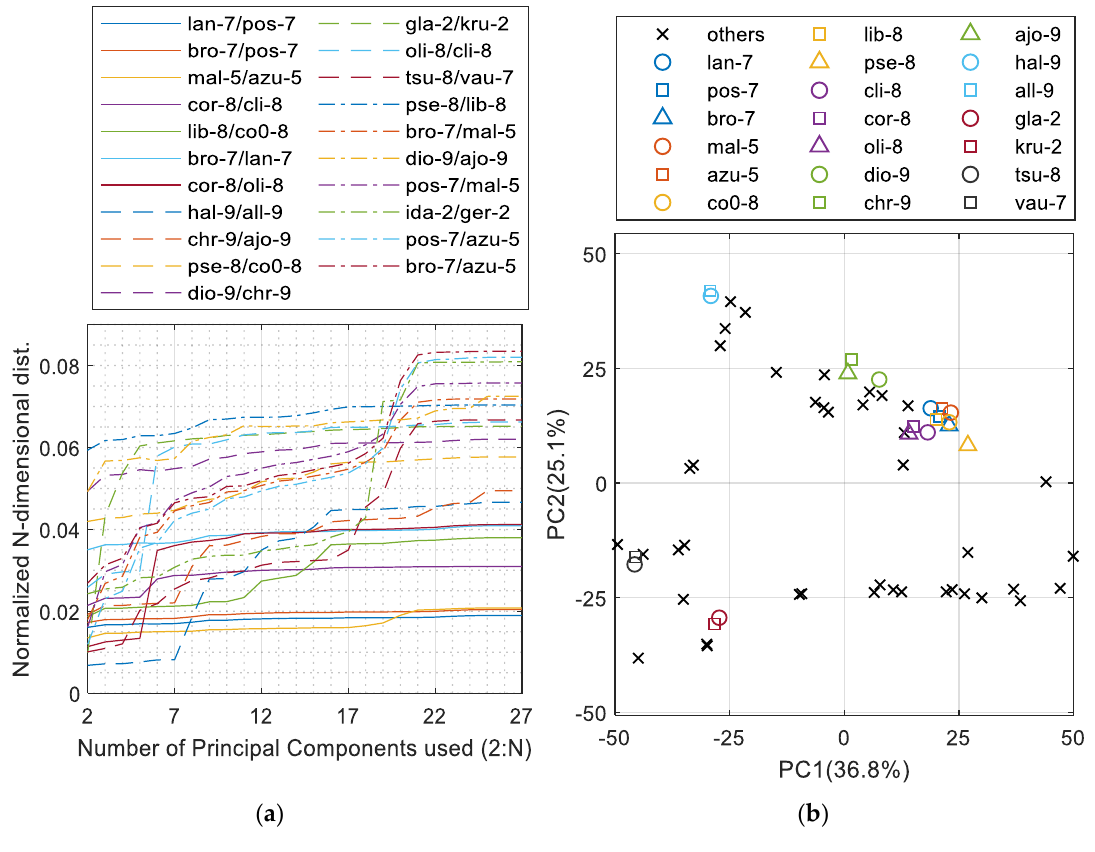
Figure 2. PCA analysis of the mineral dataset based on element composition: ( a ) the N -dimensional distance measure between the closest pairs of minerals; ( b ) 2D PCs plot indicating the most similar groups of minerals extracted.